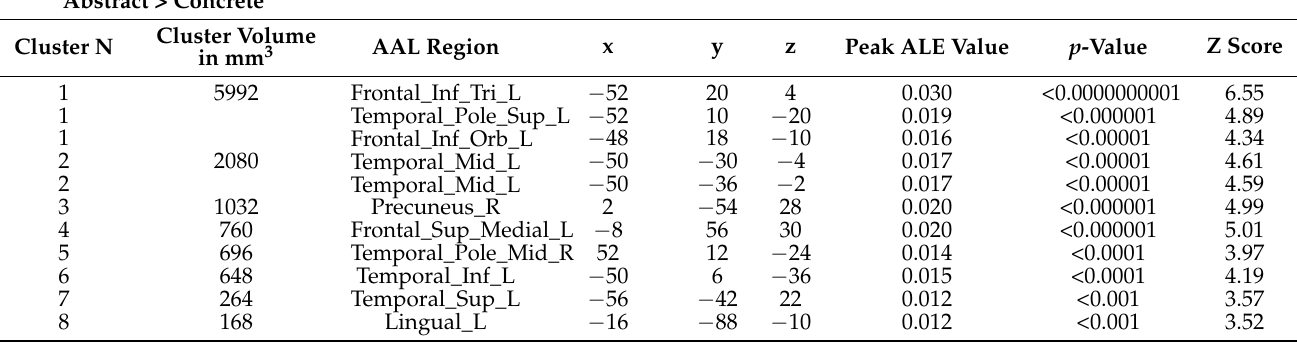
Table 4. Results for the abstract > concrete comparison. Results are reported in Montreal Neurological Institute (MNI) space with anatomical labels from the Automated Anatomical Atlas (AAL). L = left; R =